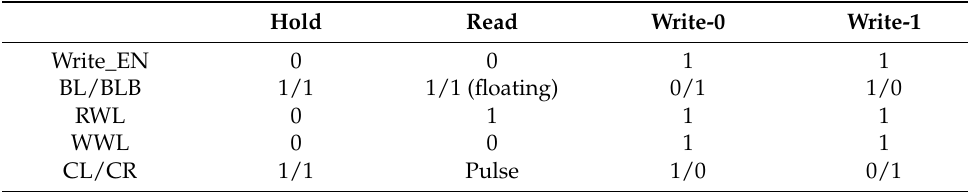
Table 1. Proposed 10T SRAM cell truth table performance: